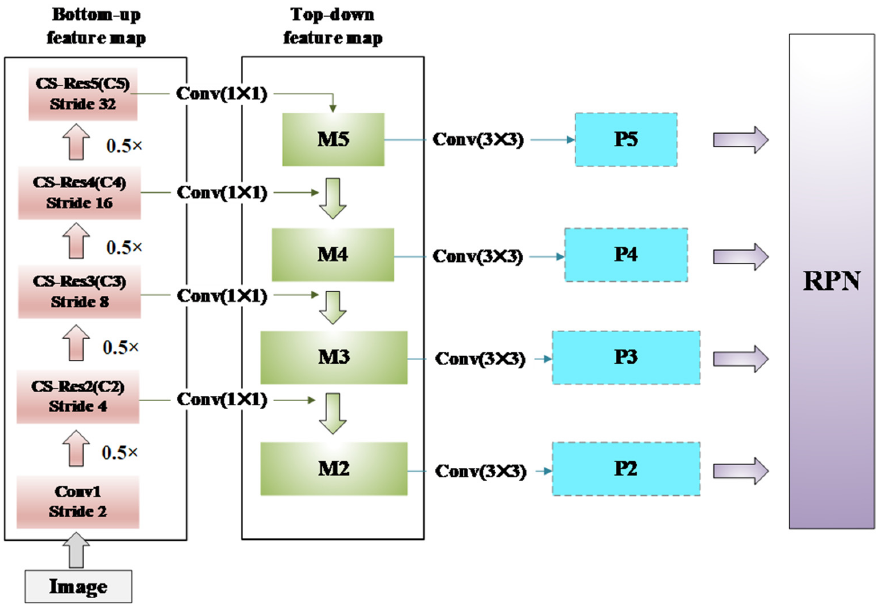
Figure 4. Schematic diagram of the FPN module structure.